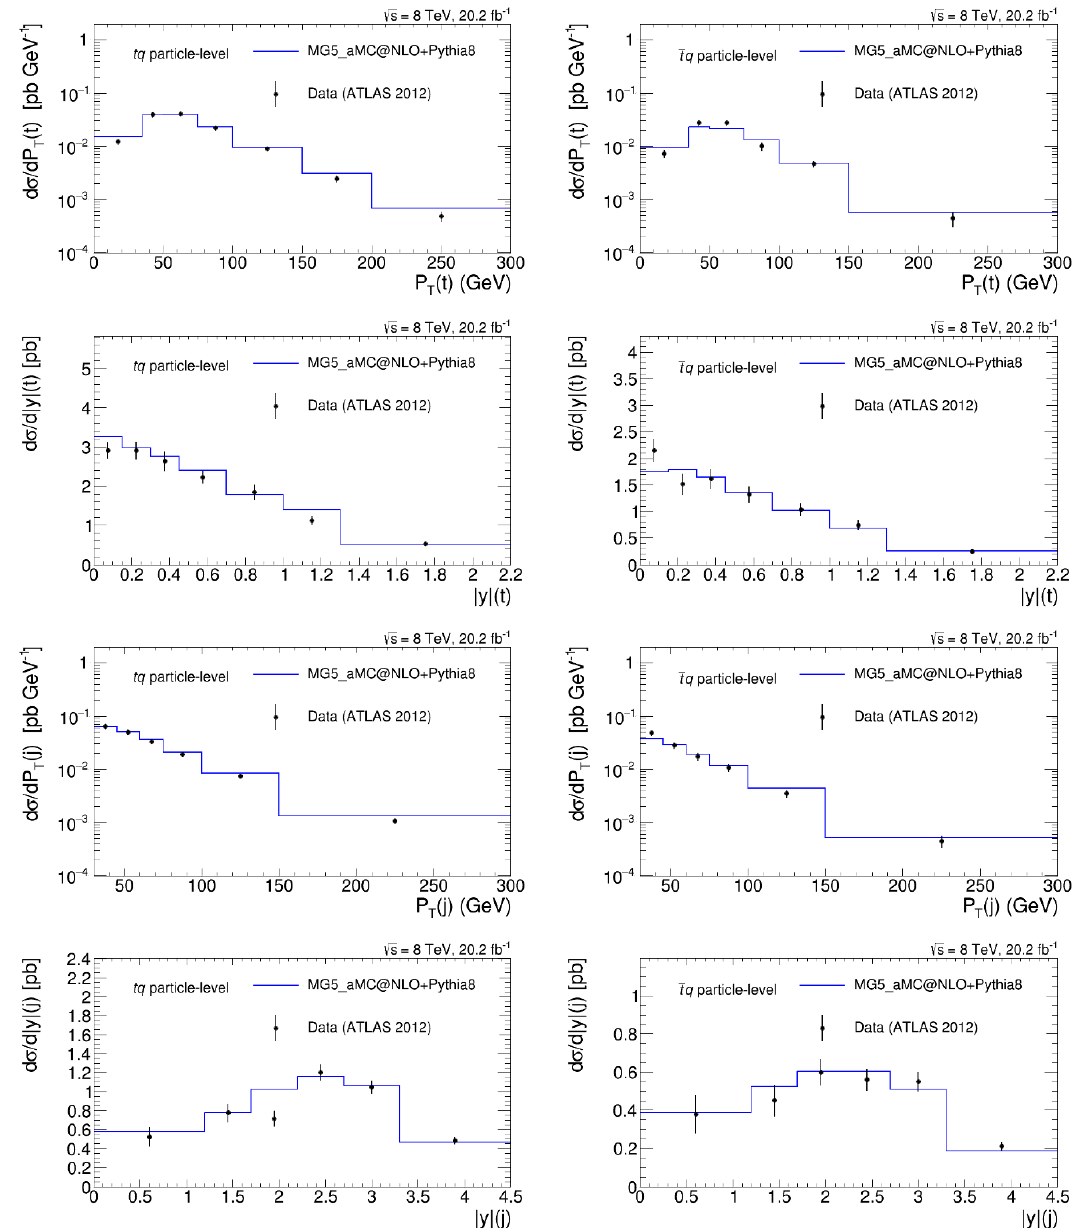
Figure 3 . Absolute di(cid:11)erential single top (left) and anti-top (right) quark cross sections at particle level as a function of the top p T ((cid:12)rst row), top j y j (second row), forward jet p T (third row) and forward jet j y j (fourth row). Data are taken from ref. [22] (ATLAS Collaboration, 8 TeV) and are compared to the SM prediction using the MC samples generated by MadGraph a mc@NLO interfaced to Pythia for showering and hadronization.